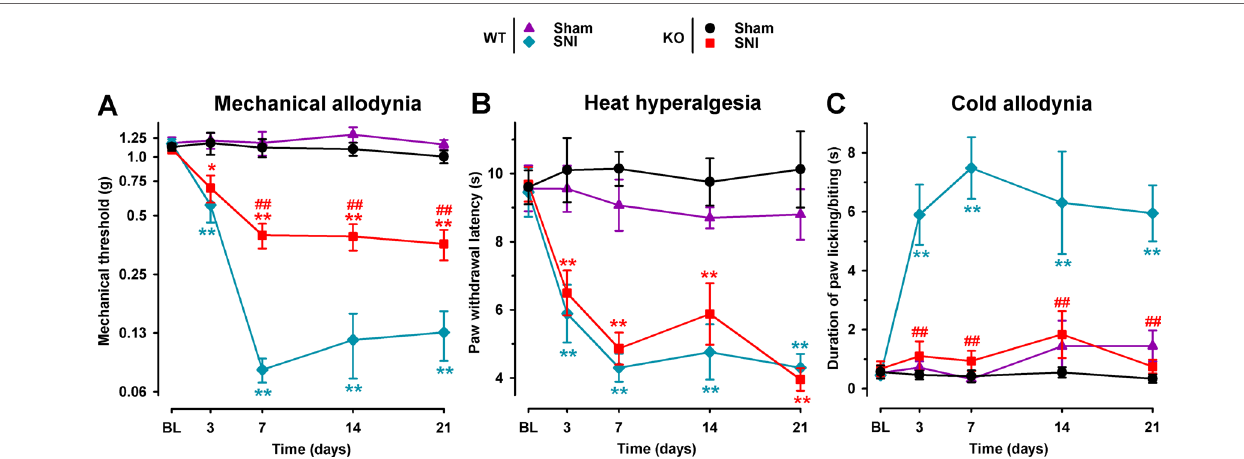
FIGURE 1 | Comparison of spared nerve injury (SNI)-induced neuropathic pain behaviors in female wild-type (WT) and σ 1 receptor knockout (KO) mice. The von Frey threshold (A) , latency to hind paw withdrawal in the Hargreaves test (B) , and duration of hind paw licking or biting in the acetone test (C) were recorded 1 day before (baseline, BL) and on days 3, 7, 14, and 21 after surgery in the paw ipsilateral to the surgery. Each point and vertical line represent the mean ± SEM of the values obtained in 10–12 animals. Statistically significant differences between the values in the sham and SNI groups on the same day: * P < 0.05; ** P < 0.01; and among WT and KO groups: ## P < 0.01 (two-way repeated-measures ANOVA followed by Bonferroni